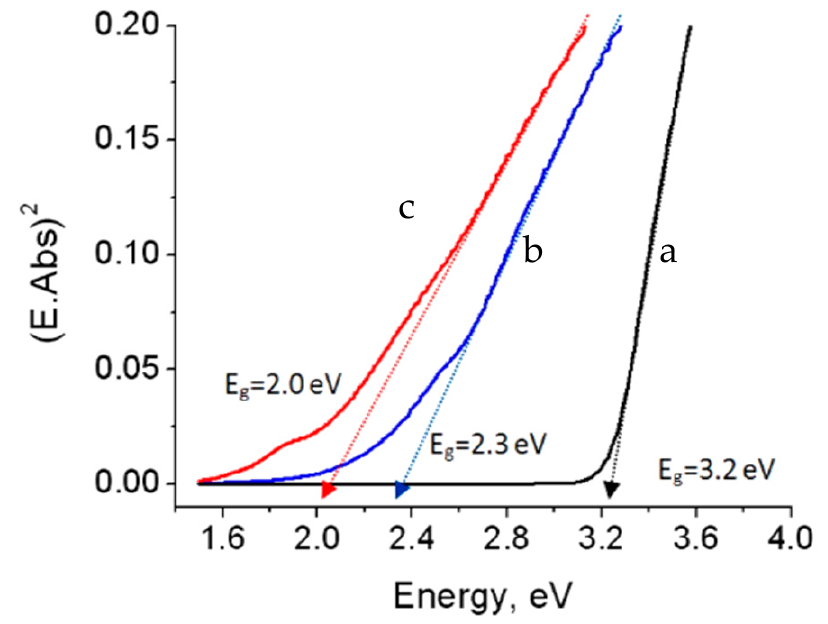
Figure 8. Band gap energy of: ( a ) BT nano commercial, ( b ) BT2-900 and ( c ) BT1-900.